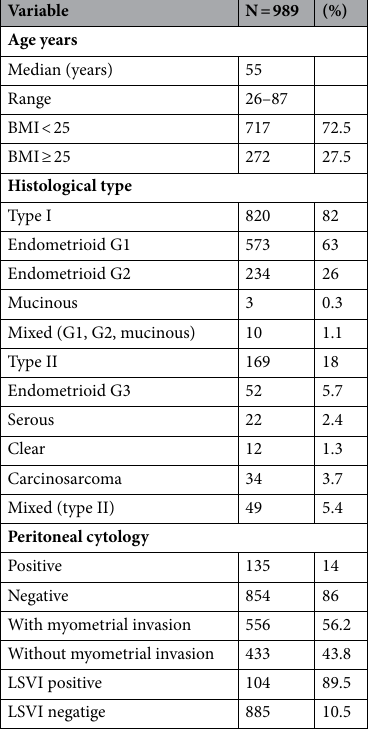
Table 1. Patient, disease, and treatment characteristics of all the patients (n = 989). BMI body mass index; Without myometrial invasion: endometrial cancer in which the malignant cells are histopathologically found only in the endometrium; myometrial invasion: endometrial cancer with myometrial invasion within 50%; LSVI lymphovascular space invasion.